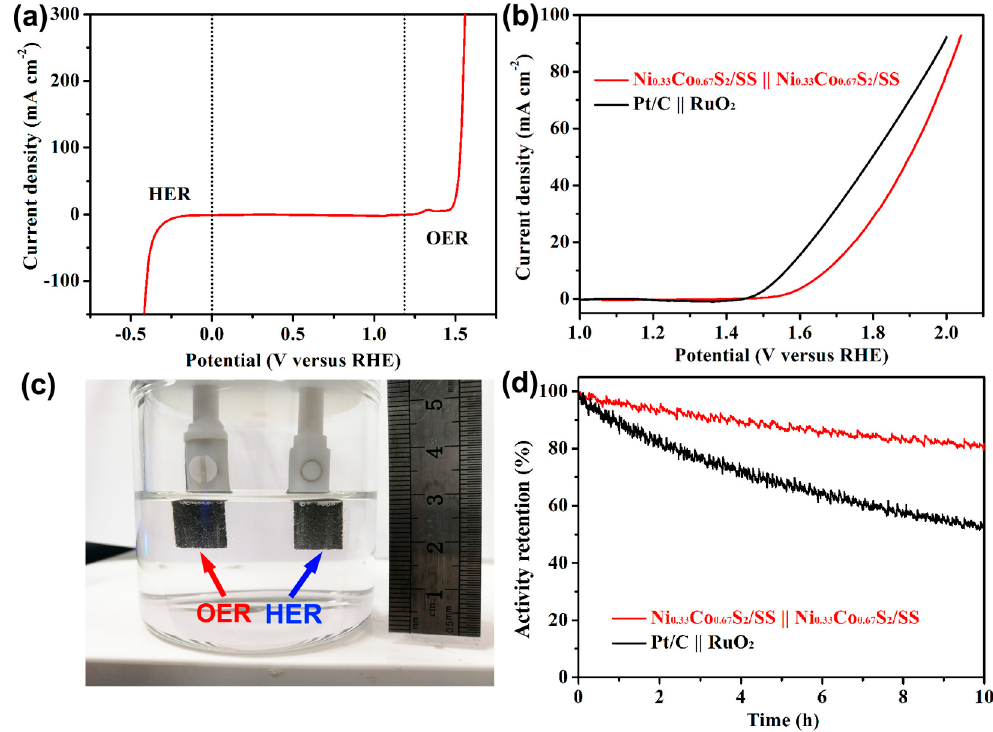
Figure 8. ( a ) Polarization curve of Ni 0.33 Co 0.67 S 2 NN/SS, collected in a three-electrode configuration, with the potential ranging from − 0.4 to 1.6 V; ( b ) Overall water-splitting performance tested by a two-electrode configuration in 1.0 M KOH; ( c ) Image of the H 2 and O 2 gas evolution on Ni 0.33 Co 0.67 S 2 NN/SS electrodes. The size of both the electrodes is 1 cm × 1 cm; ( d ) Long-term catalytic stability of fabricated electrolyzers at a fixed potential of 1.7 V.